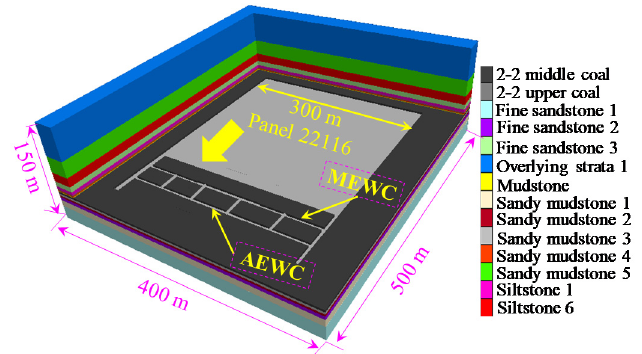
Figure 9. 3D view of the numerical model.